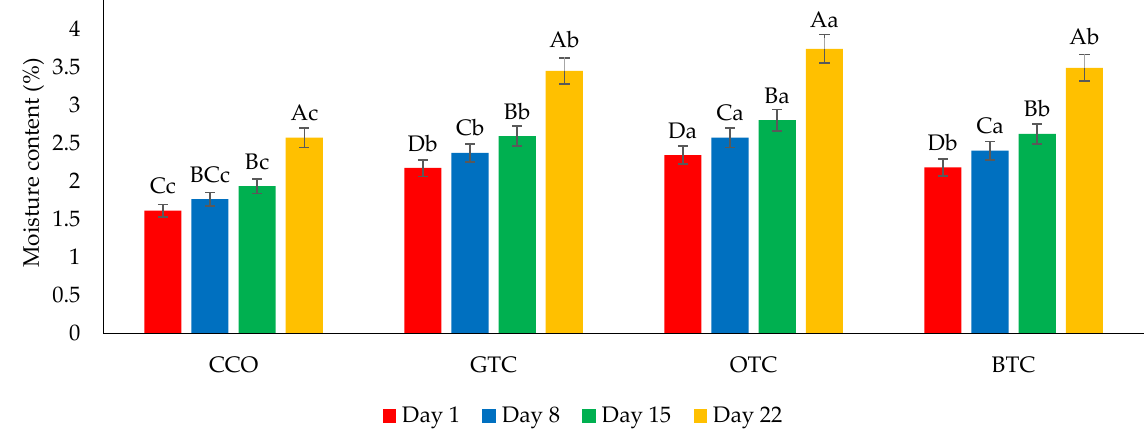
Figure 4. The moisture content of non-gluten shortbread cookies with various spent tea leaf powders during different storage periods (day 1, 8, 15, and 22) at 25 ◦ C. The mean ± SD ( n = 3). Different letters indicate significant differences between the values (Duncan’s multiple range test, p < 0.05, a–c cookie samples, A–D storage). CCO = control; GTC = non-gluten shortbread cookies with spent green tea leaves powder; OTC = non-gluten shortbread cookies with spent oolong tea leaves powder; and BTC = non-gluten shortbread cookies with spent black tea leaves powder.